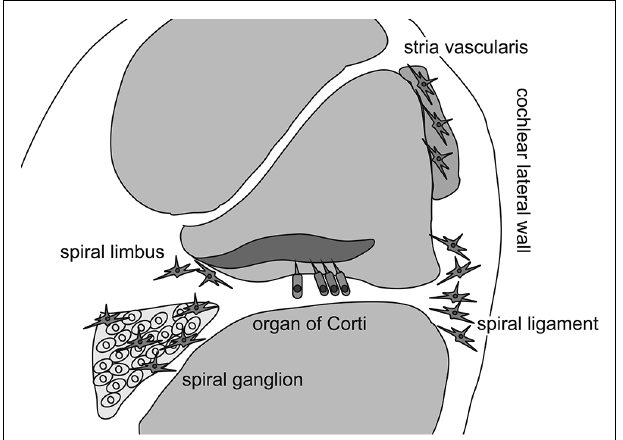
FIGURE 1 | Distribution of cochlear macrophages. Schematic drawing shows the cross section of the cochlear duct. Cochlear macrophages reside in the spiral ligament and spiral limbus where fibrocytes are located to keep ion exchanges. In addition, macrophages are distributed in the spiral ganglion. Finally, macrophage-like melanocytes are observed in the intermediate layer of the stria vascularis.